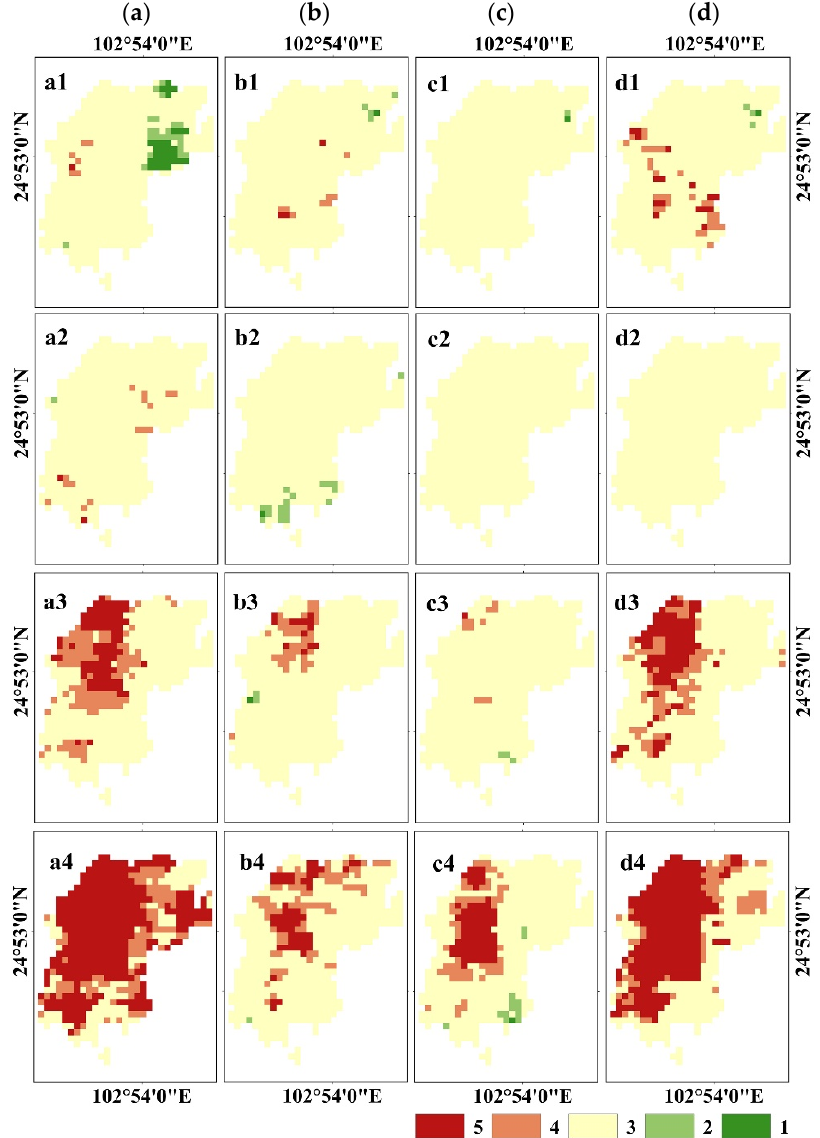
Figure 7. Spatial change rate of DI in Chenggong District from 2001 to 2020. Note: Colors 1–5 in the figure represent the trend of significant negative growth, negative growth, unchanged, positive growth, and significant positive growth, respectively. ( a – d ) represent the spatial change rate of DI in June, July, August, and the year, respectively. Figures 1–3 show the spatial change rate in the pre-UT period (2001–2010), in the post-UT period (2010–2020), and the overall (2001 – 2020).